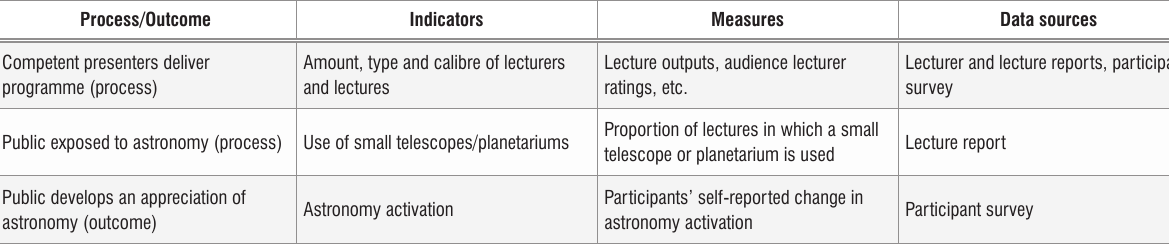
Process and outcome indicators and measures for the Programme for the Public Process/Outcome Indicators Measures Data